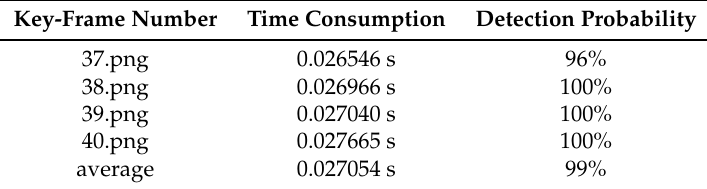
Table 6. Average time consumption and detection probability.